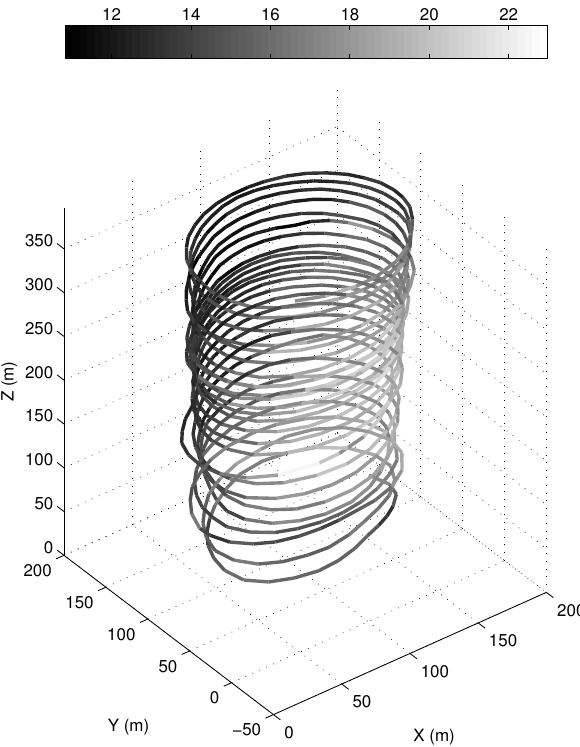
Fig. 4: Derived wind profile by using the BCF on the flight shown in Fig. 2. 18